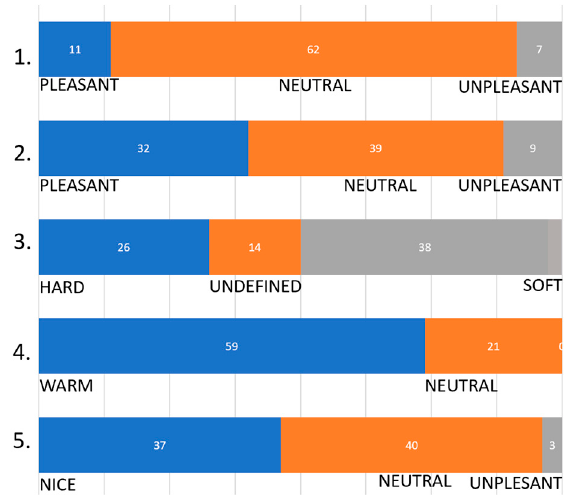
Figure 8. Results of test A—consumer test on a three-degree scale, presented in a cumulative percentage graph.